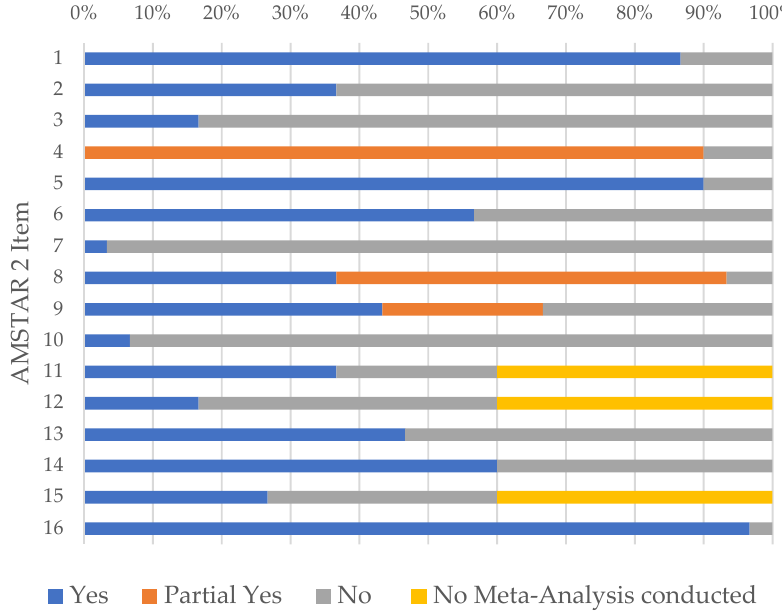
Figure 1. Item ratings on AMSTAR 2 in 30 SRs.